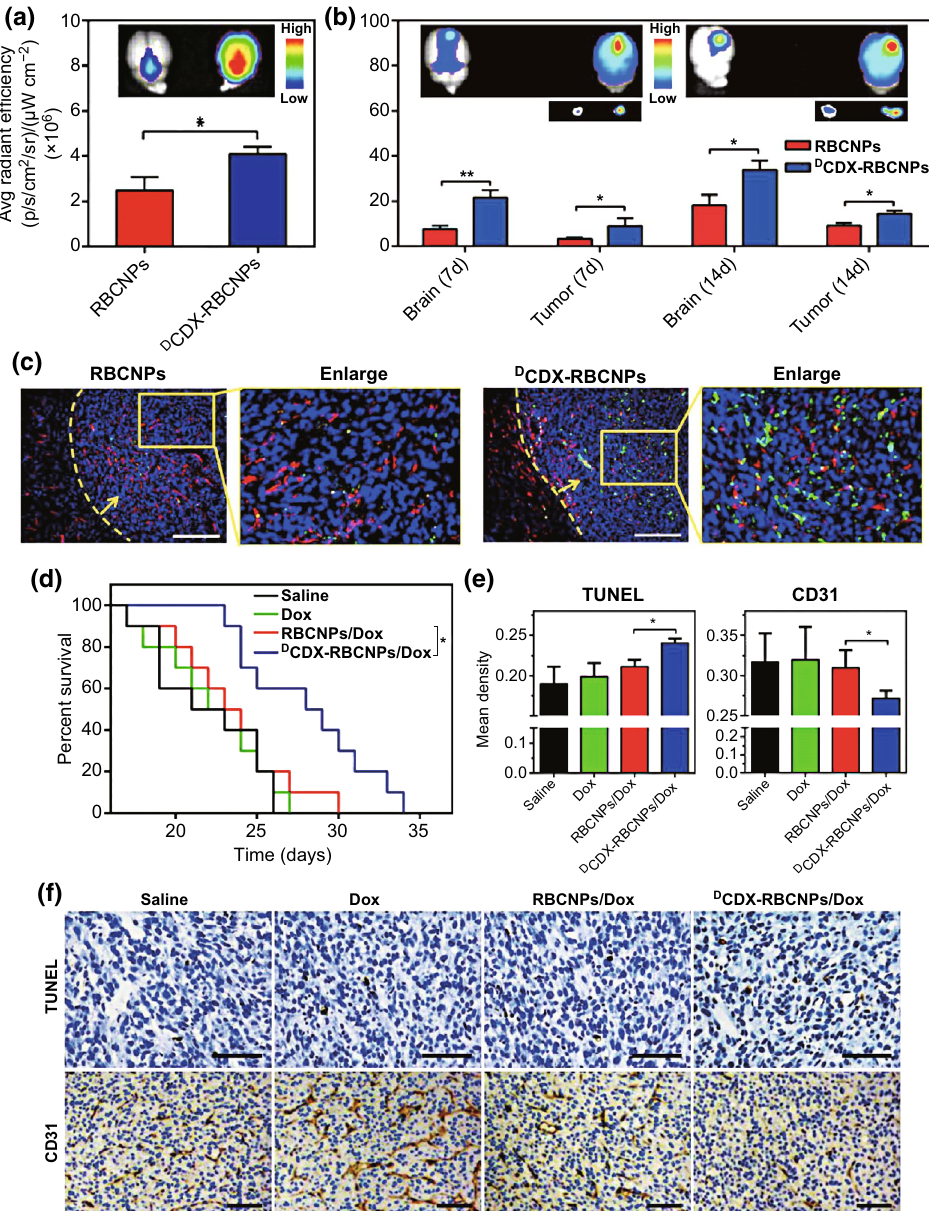
Fig. 3 a, b Normal radiance values and images of the brains of normal nude mice and of brains bearing gliomas at days 7 or 14 of tumor pro‑ gression. Mean ± SD, n = 3, *p < 0.05, **p < 0.005. c NP localization on day 14 post‑tumor implantation, with DAPI (blue) representing nuclear staining, CD31 (red) indicating vasculature, and green indicating NPs. Glioma margin is demarcated by a yellow dotted line, and the tumor is indicated by a yellow arrow; Scale bar = 200 µm. d Survival of intracranial U87 glioma‑bearing mice calculated via the Kaplan–Meier method. On days 7, 9, 11, 13, and 15 following tumor implantations, animals ( n = 10) were injected using either saline as a vehicle control, or with free DOX, DOX‑loaded RBC NPs (RBCNPs/DOX), and DOX‑loaded D CDX‑RBC NPs ( D CDX‑RBCNPs/DOX). e Integral optical density (IOD) values for tumors from differentially treated mice following either TUNEL staining or CD31/PAS dual staining. Mean density = IOD (SUM)/ Area. Mean ± SD, n = 3, *p < 0.05. f TUNEL staining and CD31/PAS dual staining analysis of tumors. Scale bar = 100 µm. Adapted from